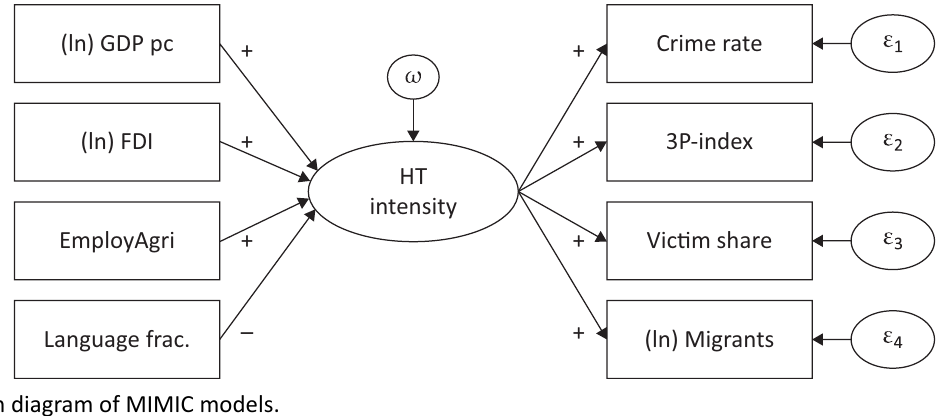
Figure 1. Path diagram of MIMIC